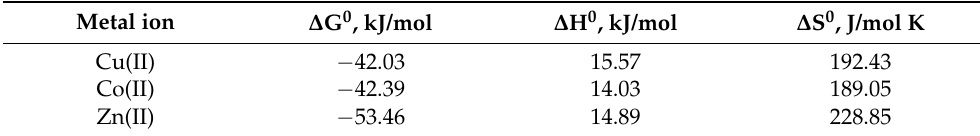
Table 3. Thermodynamic parameters obtained at the biosorption of Cu(II), Co(II) and Zn(II) ions on Alg-Fe 3 O 4